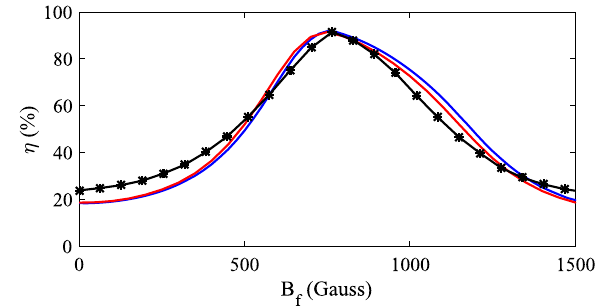
with E c; of pulse max 42 MV = m c; max of